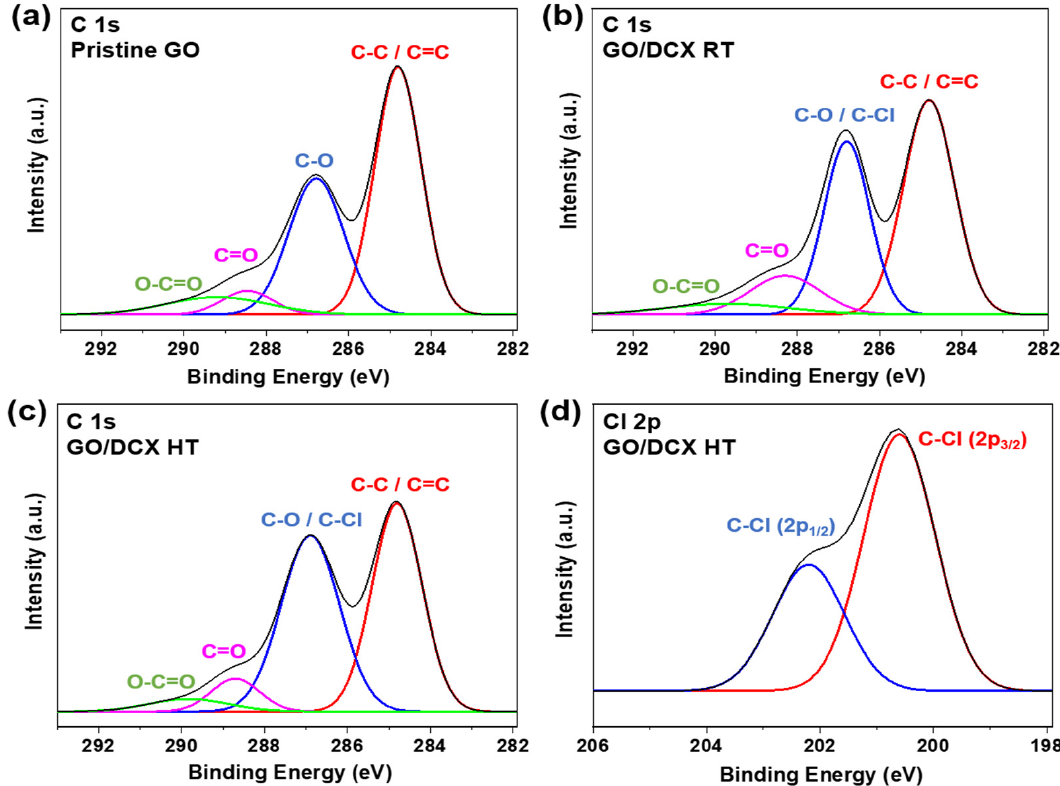
Figure 4. Deconvoluted C 1s XPS spectra of the ( a ) pristine GO, ( b ) GO/DCX RT, and ( c ) GO/DCX HT membranes and the ( d ) deconvoluted Cl 2p XPS spectra of the GO/DCX HT membrane.